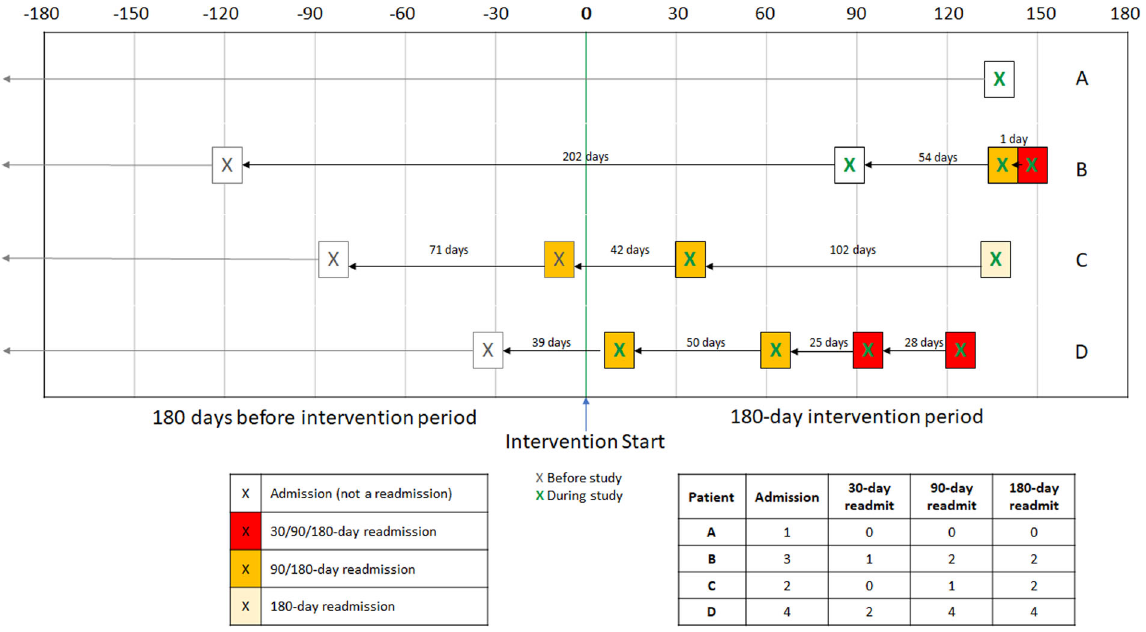
Fig. 4 Visualizing admissions and readmissions. Figure 4 illustrates four patients ’ examples on how admissions, 30-, 90-, and 180-day readmissions were counted in this